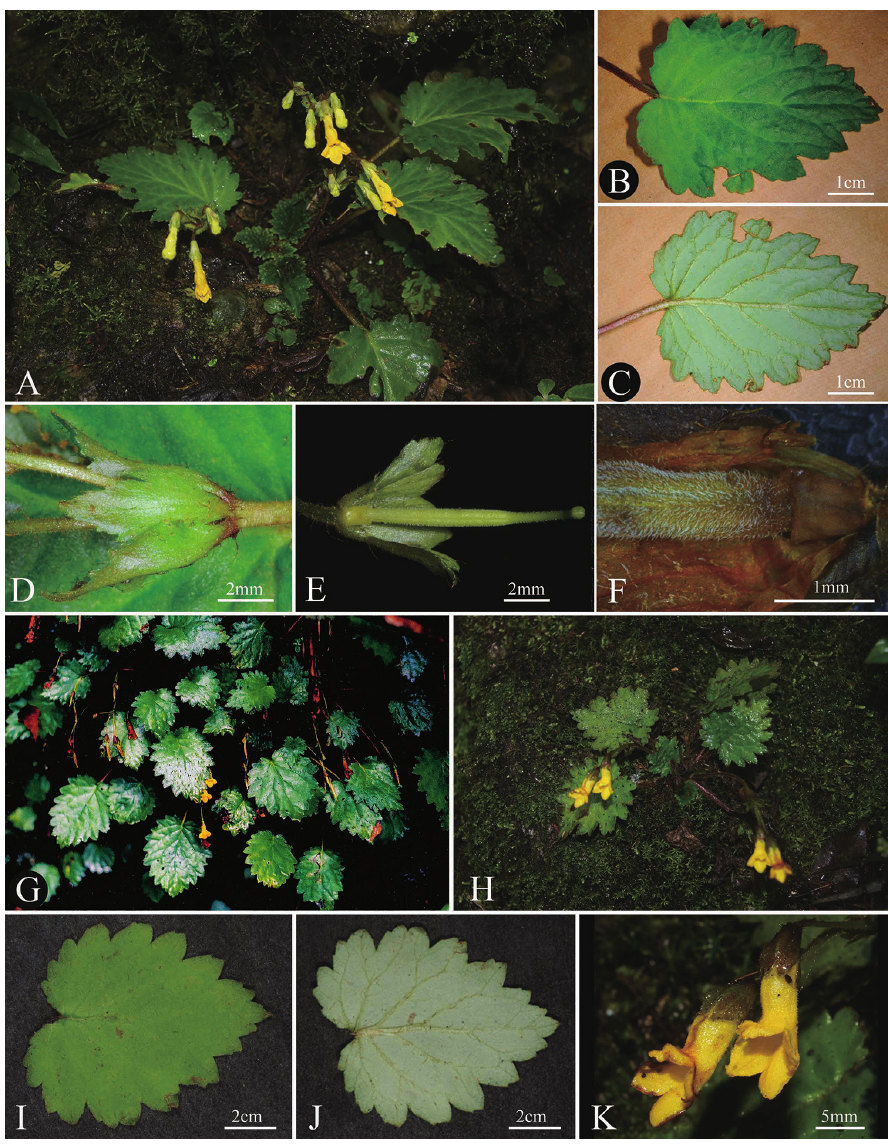
Figure 2. Oreocharis eriocarpa W.H.Chen & Y.M.Shui, sp.nov. ( A–F ) A habit B leaf adaxial surface C leaf abaxial surface D bracts E ovary and disc F dense pubescent ovary and disc; O. wenshanensis ( G–K ) G habitat H plant I leaf adaxial surface J leaf abaxial surface K flower. Photography by He De-Ming ( A–E, K ), Zhang Ting ( E ), Chen Li ( F ), Shui Yu-Min ( G, I, J